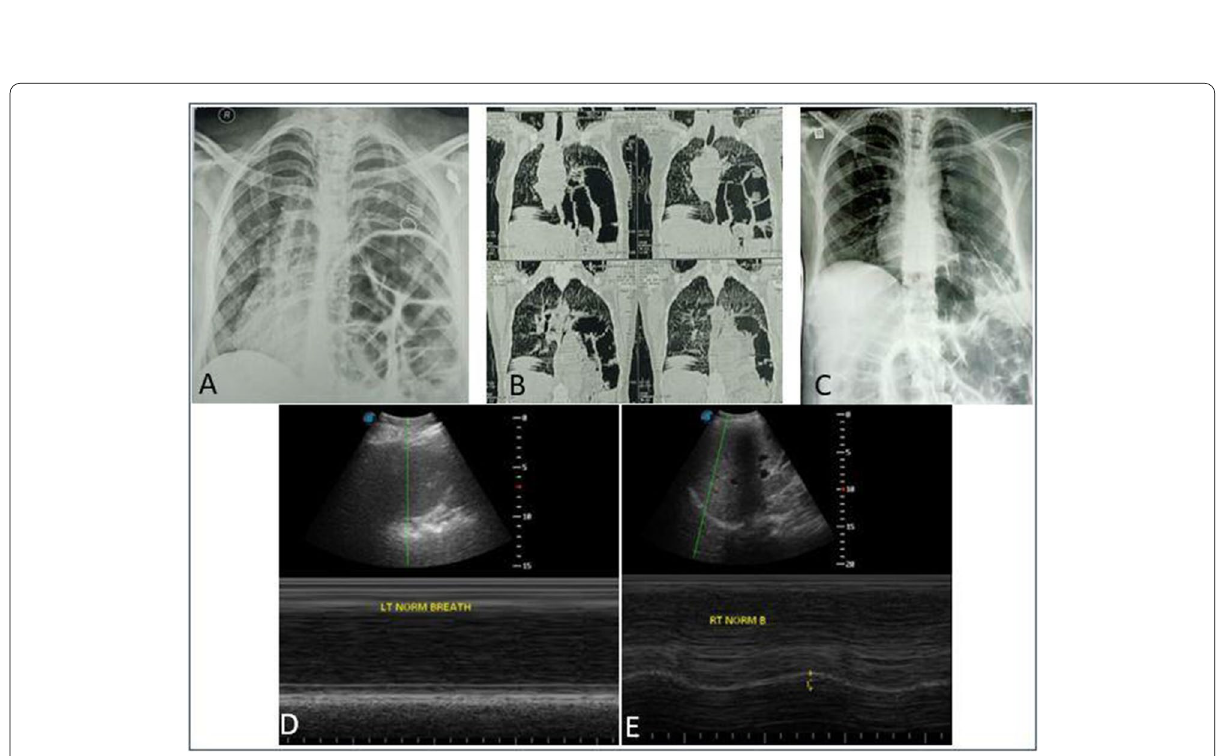
Fig. 4 Female patient 25 years old with left diaphragmatic paralysis: A Pre‑operative CXR showing significant left diaphragmatic paralysis. B CT chest images showing the intestine at the site of the paralysis. C Post‑operative CXR with an intercostal tube. D , E Pre‑operative DUS image comparing left to right